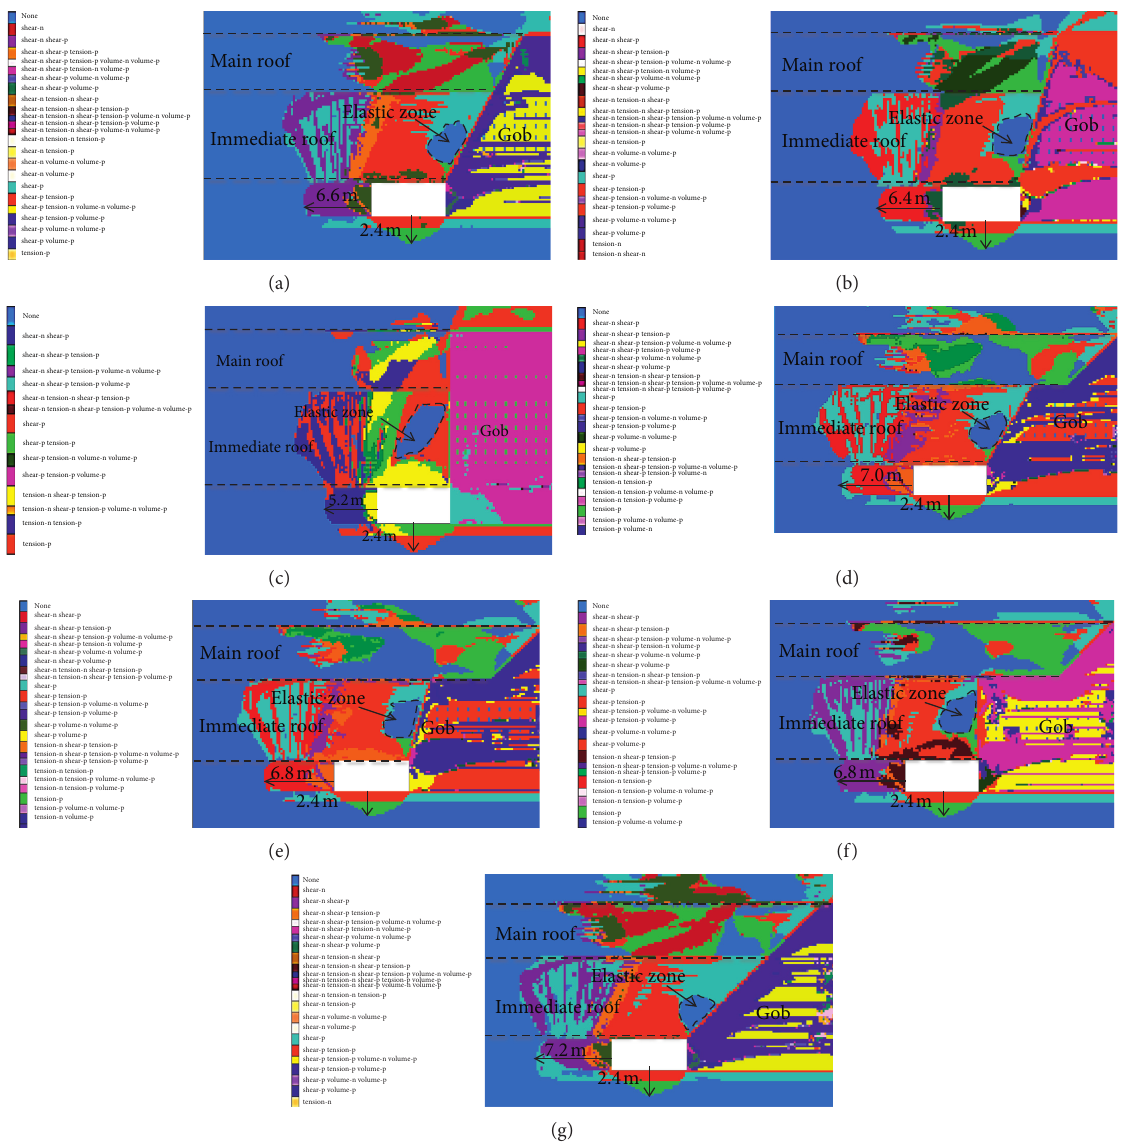
Figure 11: The plastic zone distribution under different fracturing heights and angles. (a) Case 1 (fracturing main roof with 60 ° ). (b) Case 2 (fracturing main roof with 75 ° ). (c) Case 3 (fracturing main roof with 90 ° ). (d) Case 4 (fracturing immediate roof with 90 ° ). (e) Case 5 (fracturing immediate roof with 75 ° ). (f) Case 6 (fracturing immediate roof with 90 ° ). (g) Case 7 (nonfracturing